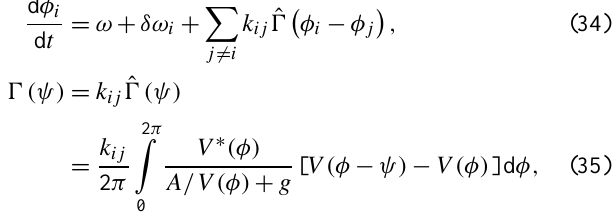
Fig. 3. A periodic orbit of the Dieterich–Ruina oscillator, a graph of (cid:0) θV (cid:1) , in a double logarithmic plane. The parameters are p /L,V/V p set to (k,V p ,g,A,B,L) = (1 . 00 × 10 5 Nm − 3 , 3 . 17 × 10 − 9 ms − 1 , 5 . 00 × 10 6 Nm − 3 s, 1 . 50 × 10 5 Nm − 2 , 2 . 20 × 10 5 Nm − 2 , 1 . 00 × 10 − 2 m). The equilibrium point is ( 1 , 1 )